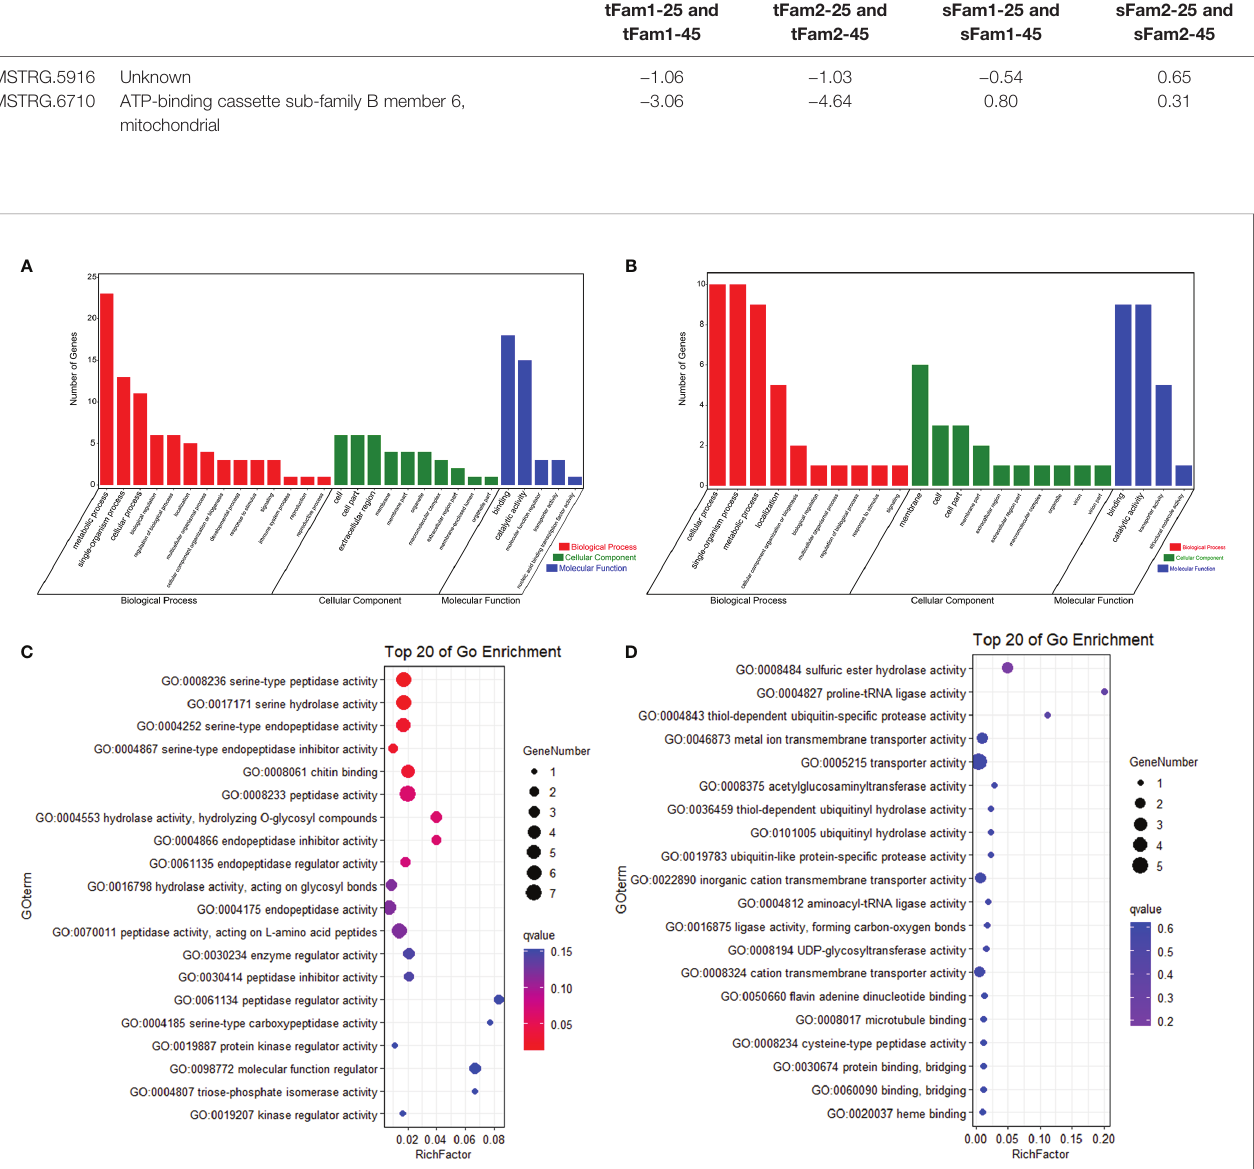
FIGURE 5 | Speci fi c DEGs in high-salinity tolerant families after high-salinity stress in Litopenaeus vannamei . (A) GO enrichment analysis of upregulated DEGs. (B) Top 20 GO terms enriched in the categories of molecular function for the upregulated DEGs, the point color shows different Q values as indicated on the right, and red color represents the signi fi cantly enriched GO term (Q < 0.05). (C) GO enrichment analysis of downregulated DEGs. (D) Top 20 GO terms enriched in the categories of molecular function for downregulated DEGs; the point color shows different Q values as indicated on the right. DEGs, differentially expressed genes; GO, Gene